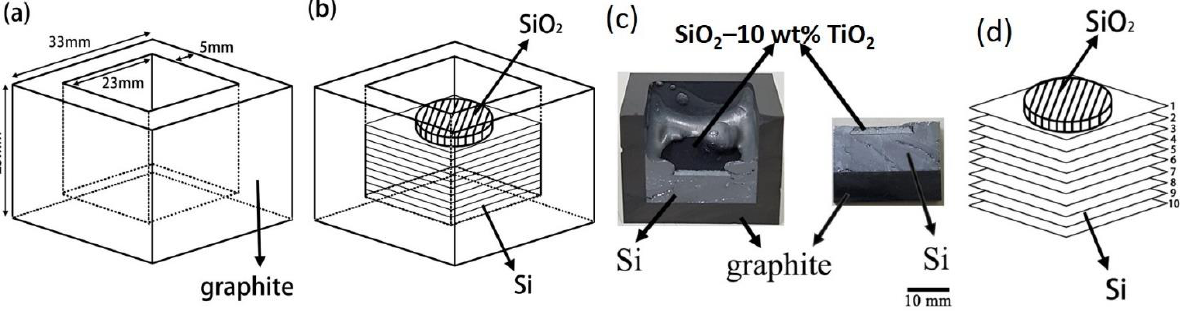
Figure 2. Schematic of ( a ) graphite crucible and ( b ) Si and SiO 2 –ceramic additive interface. ( c ) Cross-sectional photograph of Si contact with SiO 2 –TiO 2 . ( d ) Diagram of several pieces of Si cut longitudinally with respect to the interface after contact for evaluation of O concentration and electrical